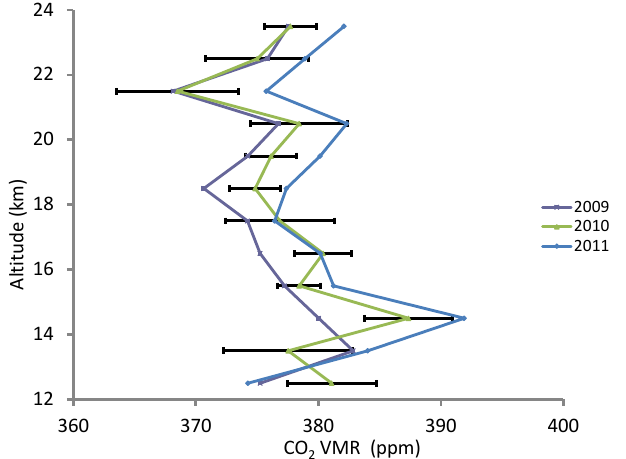
Figure 11 – Annual growth of CO 2 versus altitude using yearly medians from the cloud-1411 Figure 11. Annual growth of CO 2 versus altitude using yearly me- dians from the cloud-free data set. Error bars show the standard free dataset. Error bars show the standard error for 2010. Between 12 and 25 km and over 1412 error for 2010. Between 12 and 25km and over all latitudes, the all latitudes, the growth rate is 2.1 and 2.8 ppm/year, or 2.47±0.67 ppm/year averaged 1413 growth rate is 2.1 and 2.8ppmyear − 1 , or 2.47 ± 0.67ppmyear − 1 averaged over 2009–2011.